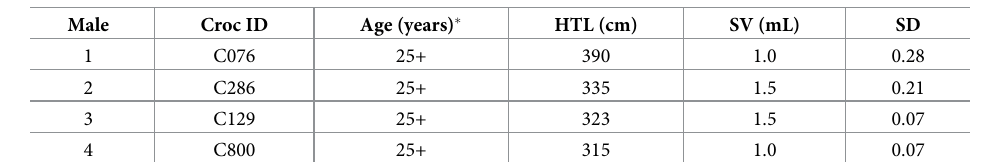
Table 1. American crocodile ( Crocodylus acutus ) semen donor information. Male Croc ID Age (years) � HTL (cm) SV (mL) SD 1 C076 25+ 390 1.0 0.28 2 C286 25+ 335 1.5 0.21 3 C129 25+ 323 1.5 0.07 4 C800 25+ 315 1.0 0.07 Animals were housed in the same pond and all males were included in the EcoTEC project. � Unknown age when wild caught (25+); HTL: Head to tail length; SV: Mean semen volume; SD: Standard